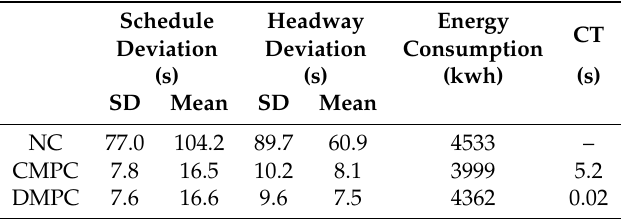
Table 1. Performance statistics of train regulation.